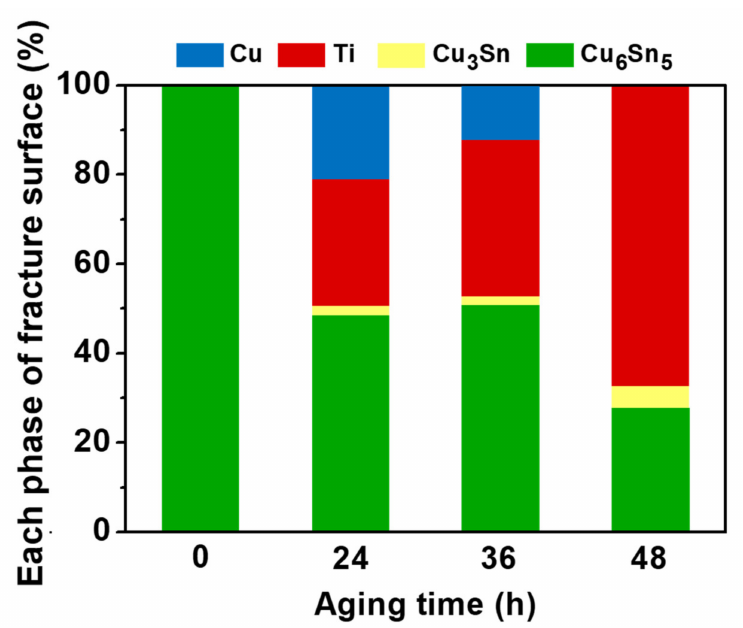
Figure 11. The phase percentages of fracture surface against aging